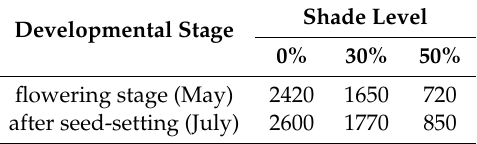
Table 4. The intensity of photosynthetically active radiation (PAR) ( µ mol photons m − 2 s − 1